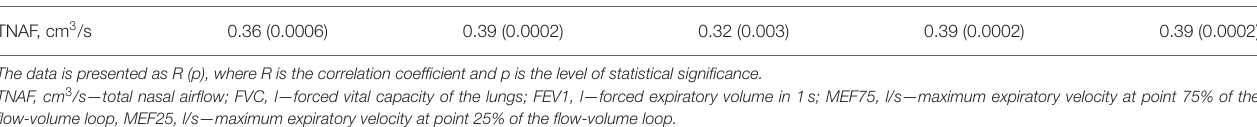
TABLE 2 | The relationship of absolute values of total nasal airflow to height and spirometry parameters in children with BA. Parameters FVC, l FEV1, l